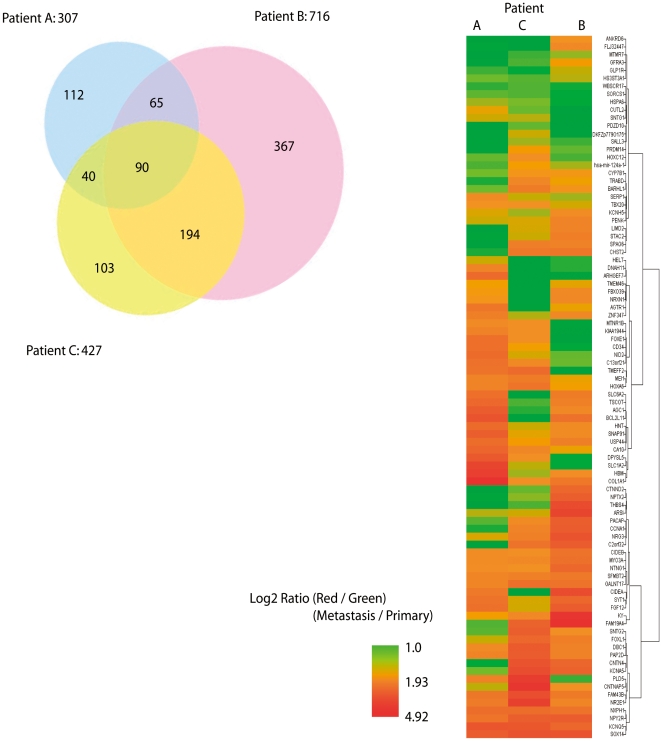
Microarray analysis of hypermethylated genes in liver metastatic cancers.A) The Venn diagram shows the overlap and differences in methylated genes of liver metastasis in three patients. A total number of 6528 genes were analyzed by 18340 microarray probes recognizing promoter CpG islands. B) Dendrogram and heat map overview of unsupervised hierarchical cluster analysis of DNA methylation in liver metastatic cancers of three patients. Each cell represents DNA methylation status of a gene in an individual sample. Red and green in cells reflect high and low methylation level, respectively, as shown in the scale bar (log2-transformed scale) below the matrix.